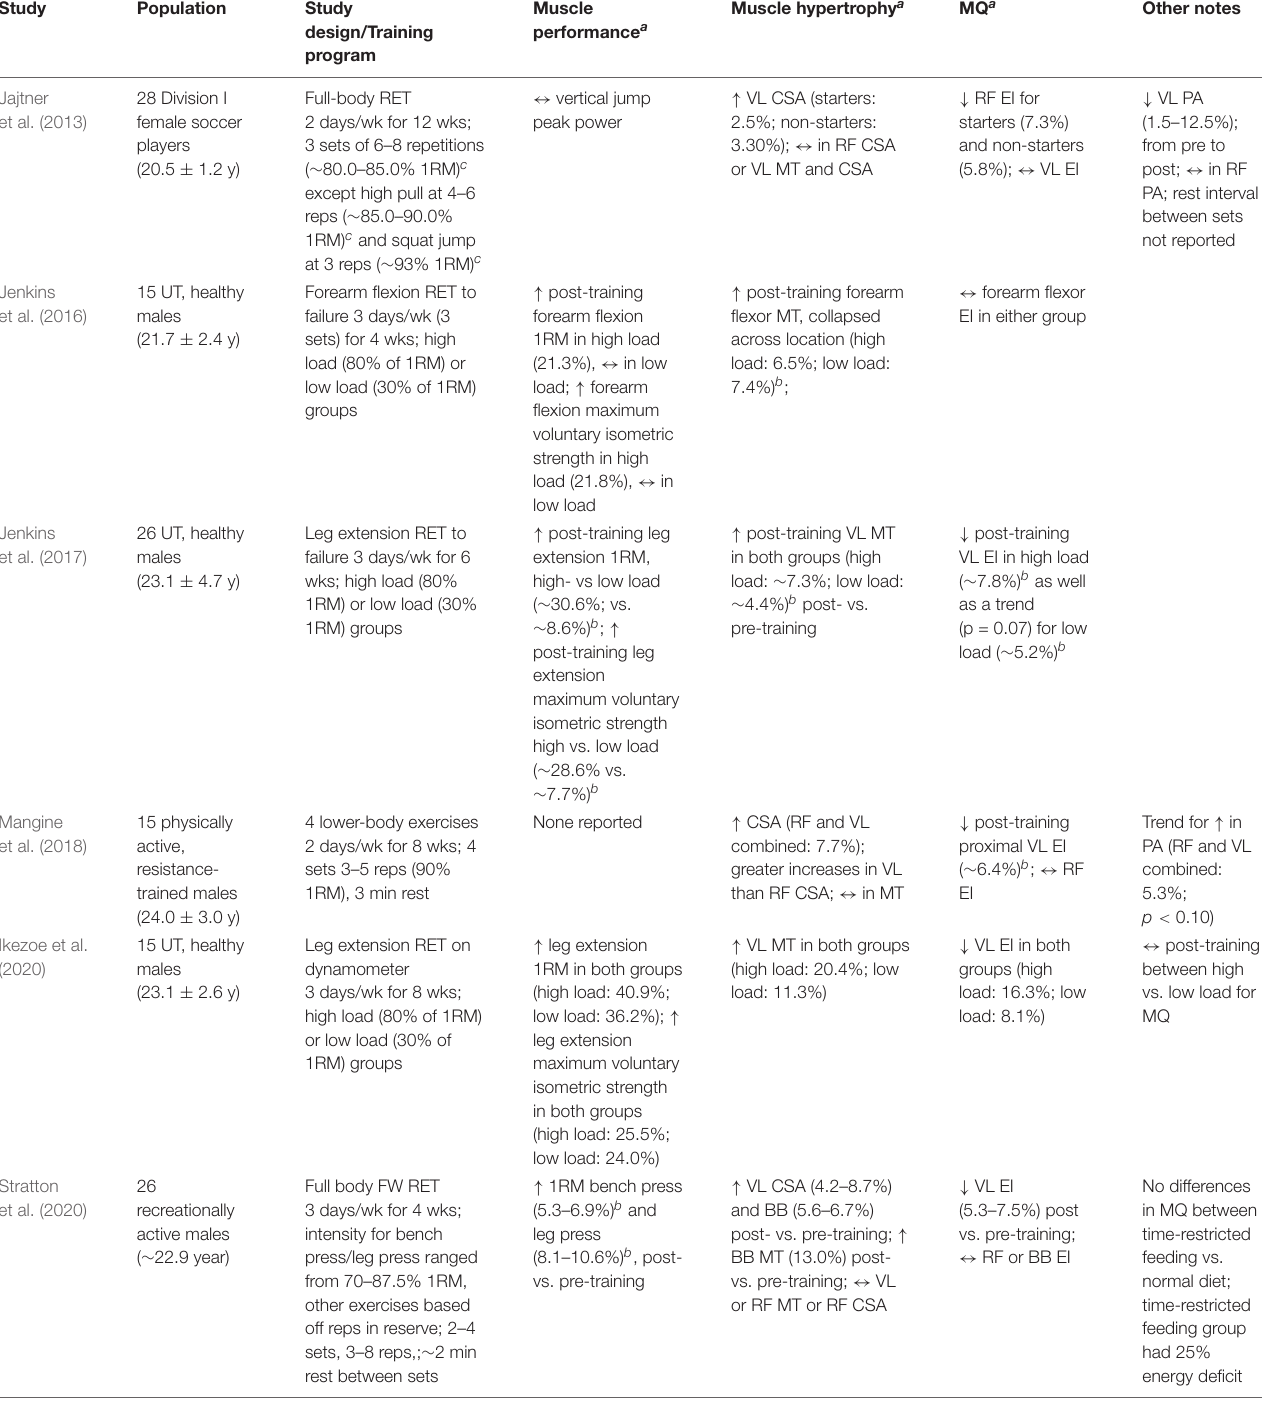
TABLE 6 | Effects of high-intensity RET on MQ measured via ultrasound-derived EI in young (18–50 years) humans. Study Population Study